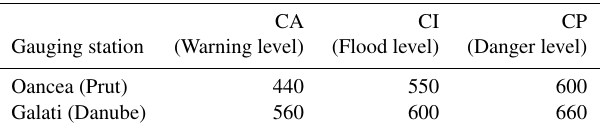
Table 3. Values of CA, CI, and CP for the Oancea (Prut) and Galati (Danube) gauging stations.